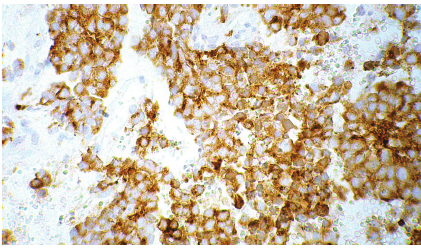
Figure 4: Small round neoplastic cells with hyperchromatic nuclei.